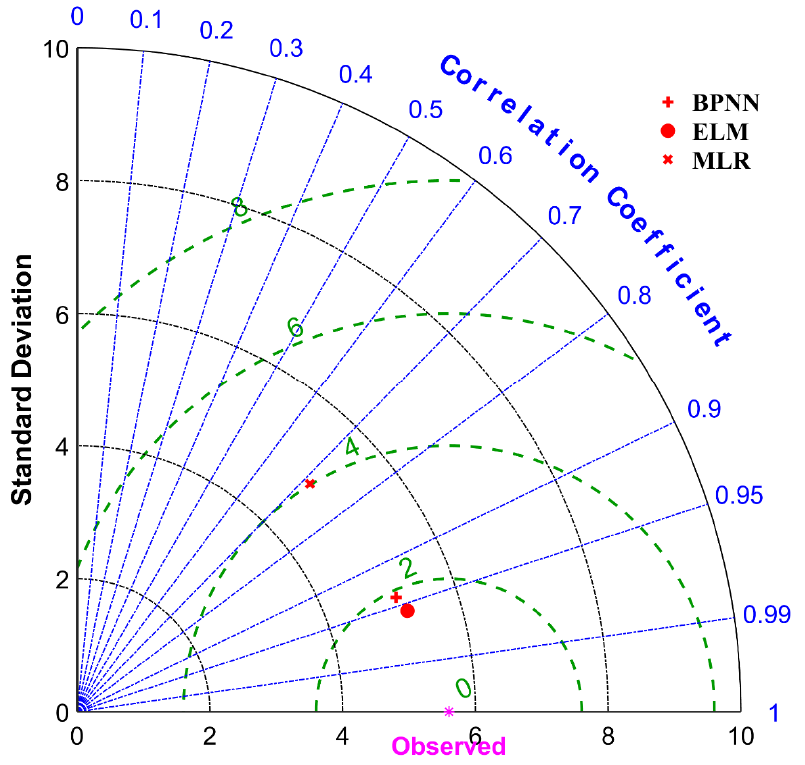
Figure 16. The Taylor diagram showing a comparison of the three developed models.